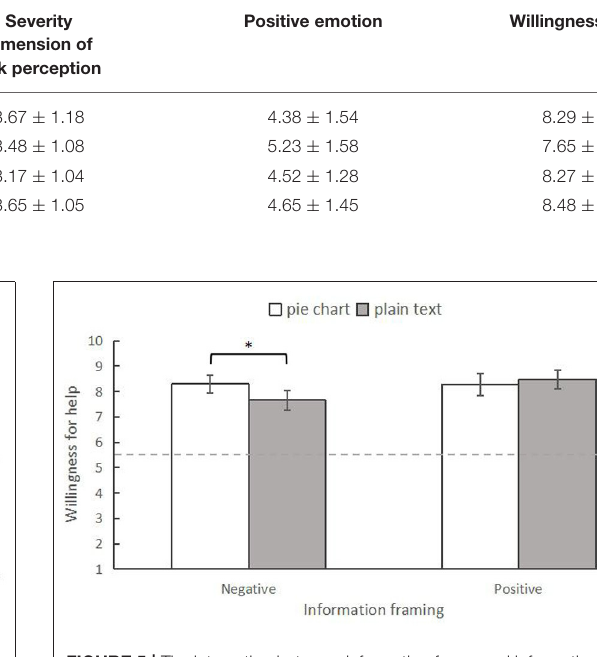
FIGURE 3 | The interaction between information frame and information form on risk perception in experiment 1. * p < 0.05. The error bars indicated 95% Confidence Intervals (95% CI).